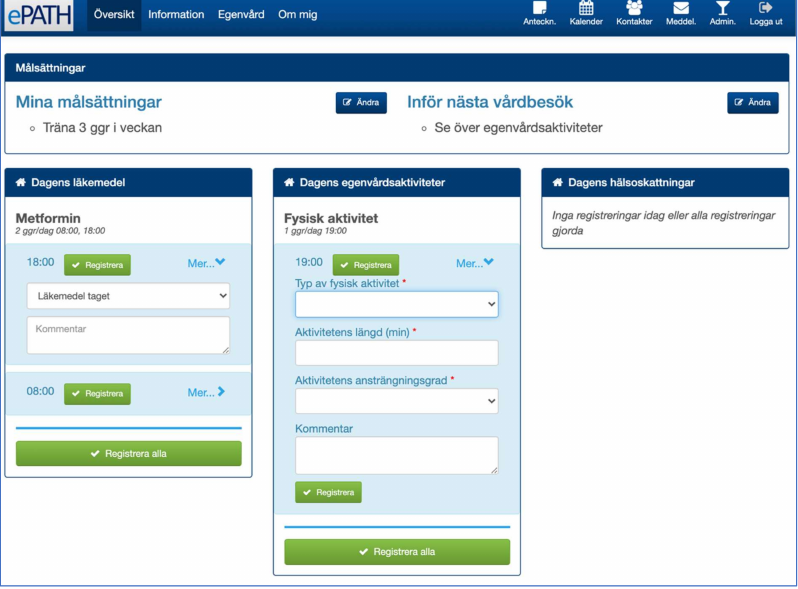
Figure 3. Screen print of the ePATH daily overview module (patient interface): The horizontal navigation panel at the top enables the patient to navigate between different modules (overview, information, self-care, about me, notes, calendar, contacts, messaging). The horizontal panel below (“Målsättningar” = Goals) enables the patient to add general goals and specific goals until the next care visit. The three vertical panels (“Dagens läkemedel” = Medications, “Dagens egenvårdsak- tiviteter” = Self-care activities, “Dagens hälsoskattningar” = Health assessments) provide an overview of the planned self-care tasks for the day and enable tracking.